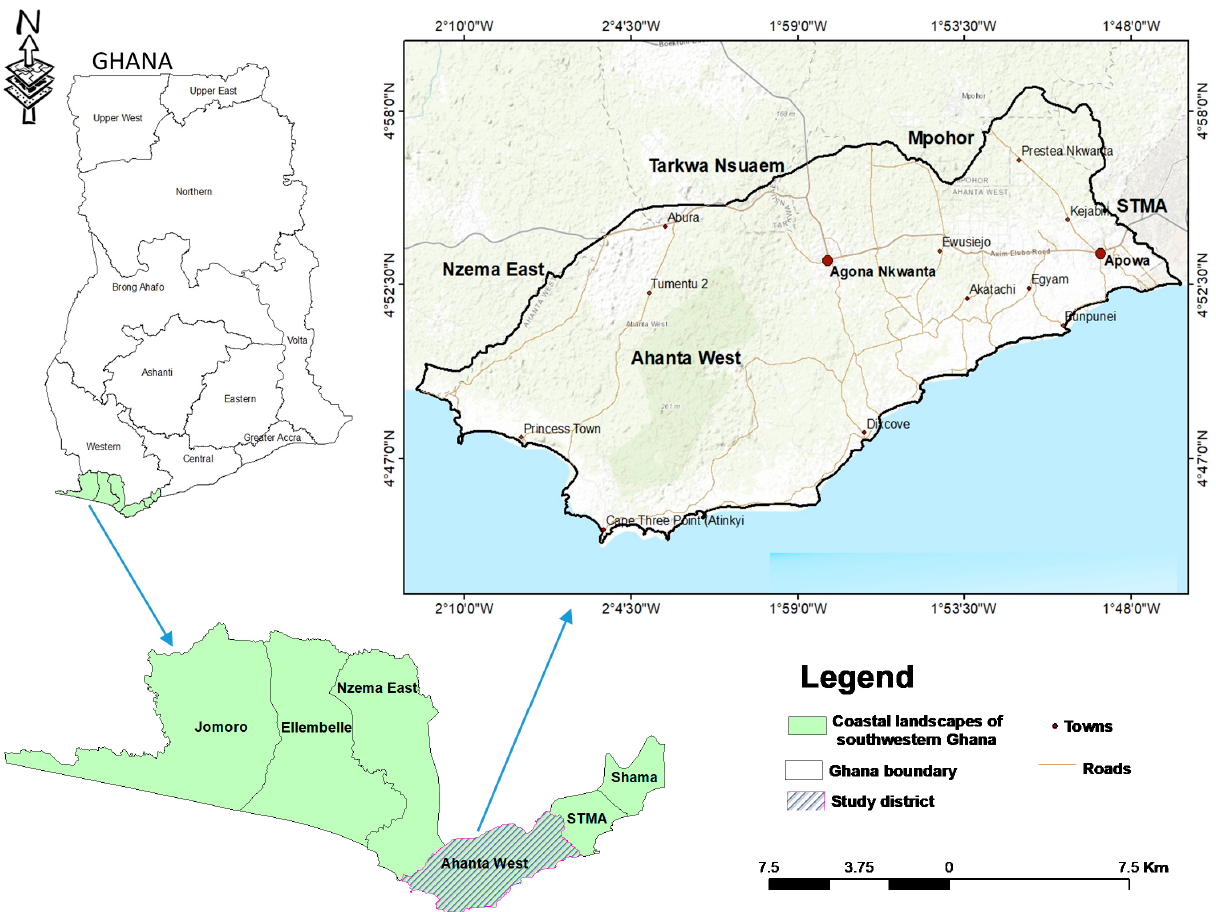
Figure 1. Location of AWMA on the coastal landscape of south-western Ghana .